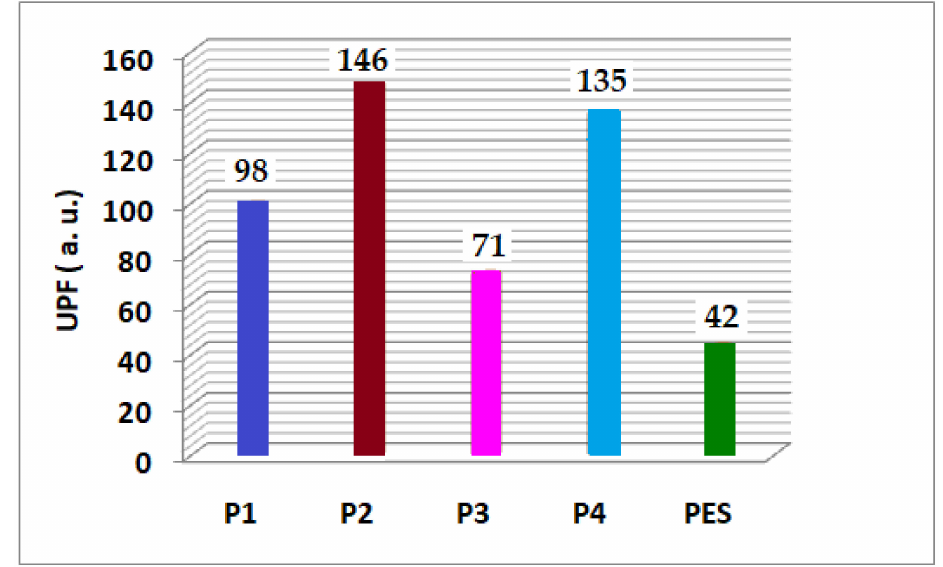
Figure 13. UV protection factor of coated textiles calculated according to EN